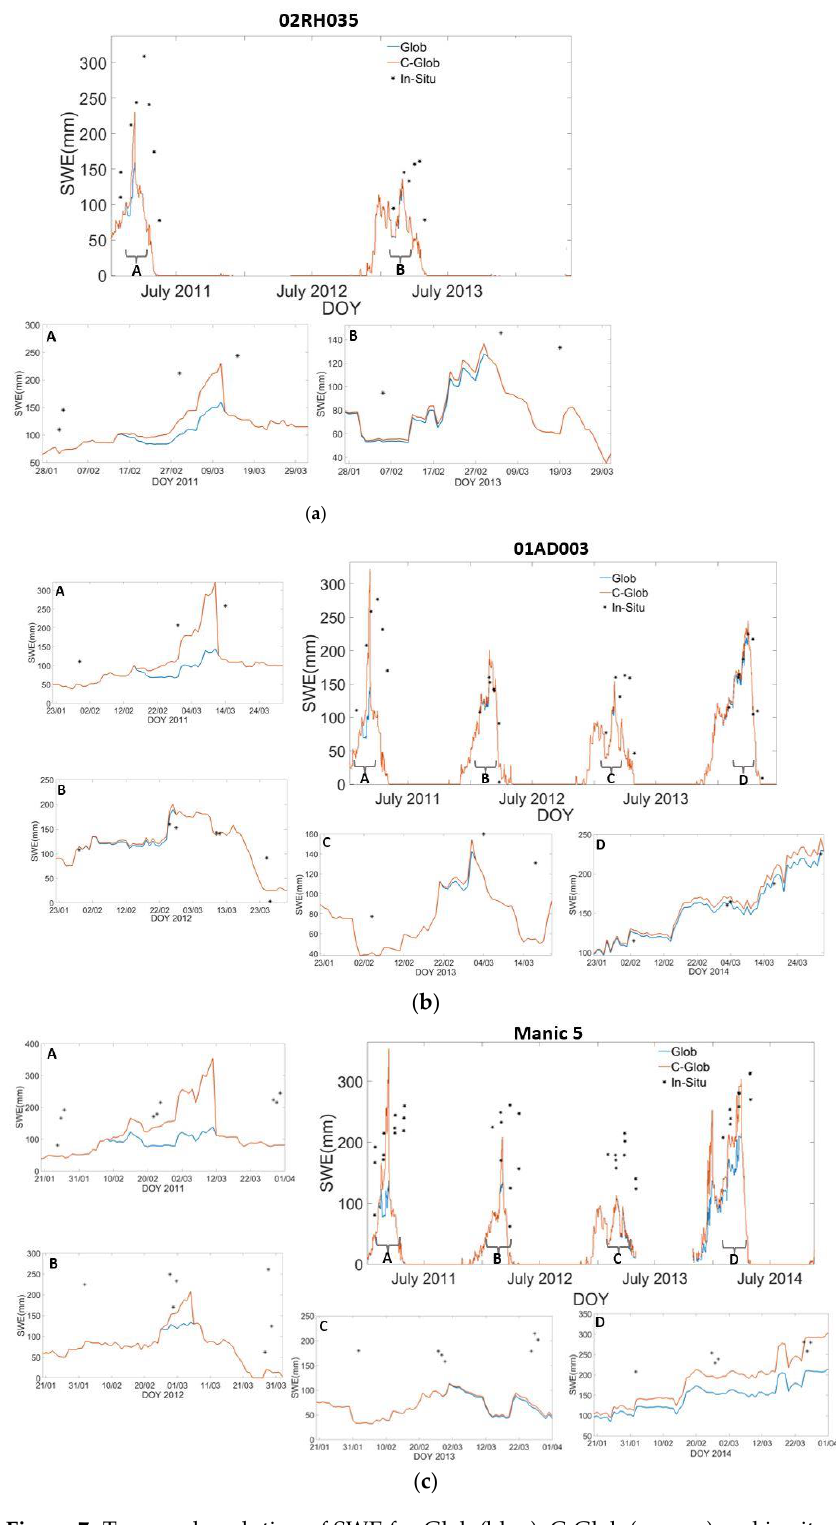
Figure 7. Temporal evolution of SWE for Glob (blue), C-Glob (orange) and in situ (black) data for watersheds ( a ) 02RH035, ( b ) 01AD003, and ( c ) Manic 5. Sub figures ( A – D ) represent specific years as indicated on the main plot. Note that no corrections are applied once SWE max is reached because the WSC approach only applies during snowpack build-up. The Glob, C-Glob, and in situ data are averaged watershed measurements.